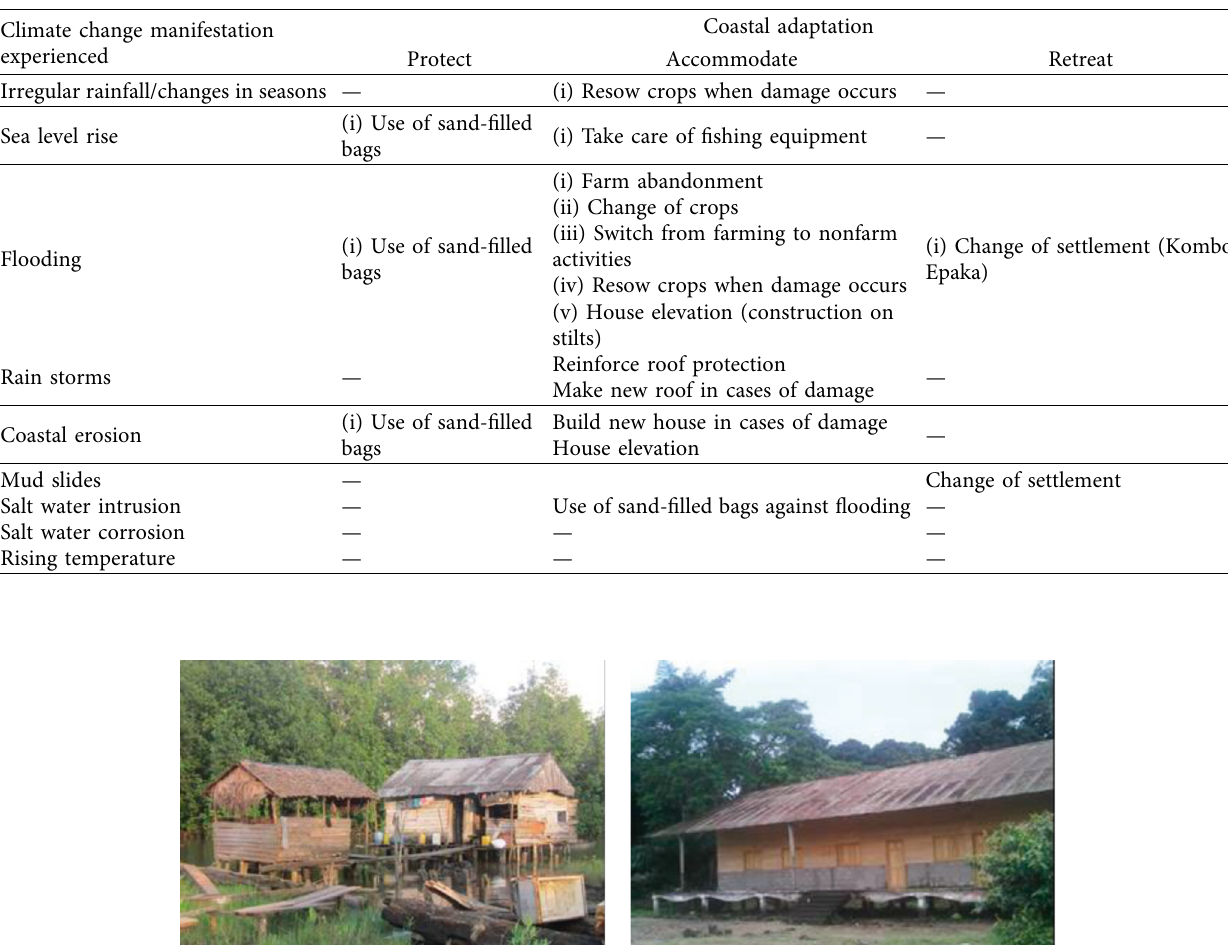
Table 6: Climate change manifestation and adaptation initiatives.